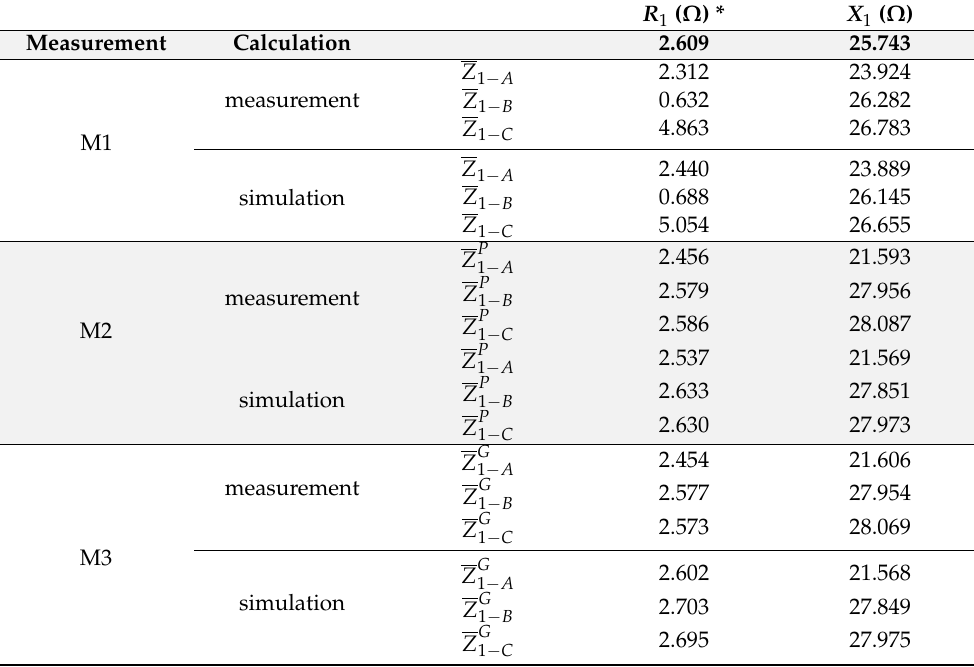
Table 7. Comparison results of positive sequence impedance per